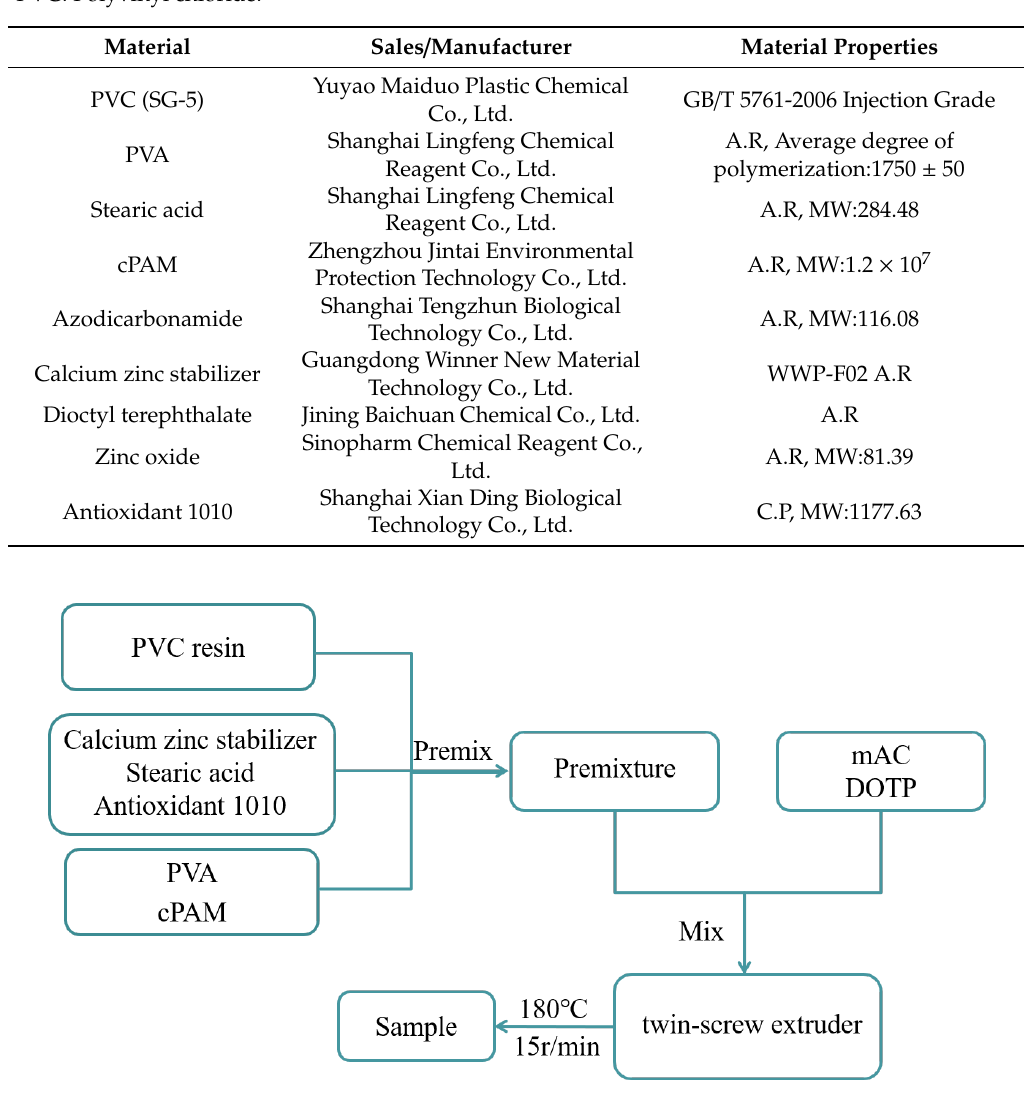
Polymers 2020 , 12 , x FOR PEER REVIEW Figure 1. Preparation of PVC biofilm carrier. Figure 1. Preparation of PVC biofilm carrier.